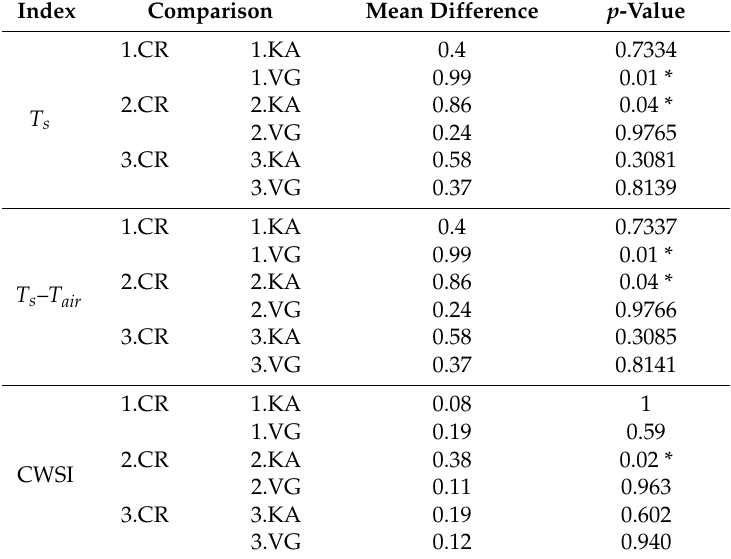
Table A2. p -values (level of statistical significance: *** p < 0.001, ** p < 0.01, * p < 0.05) of Tukey’s HSD (Honestly Significant Difference) pairwise comparison and mean differences of treatments (CR, KA, VG) for temperature-based indices at all three Hyper - Cam LW